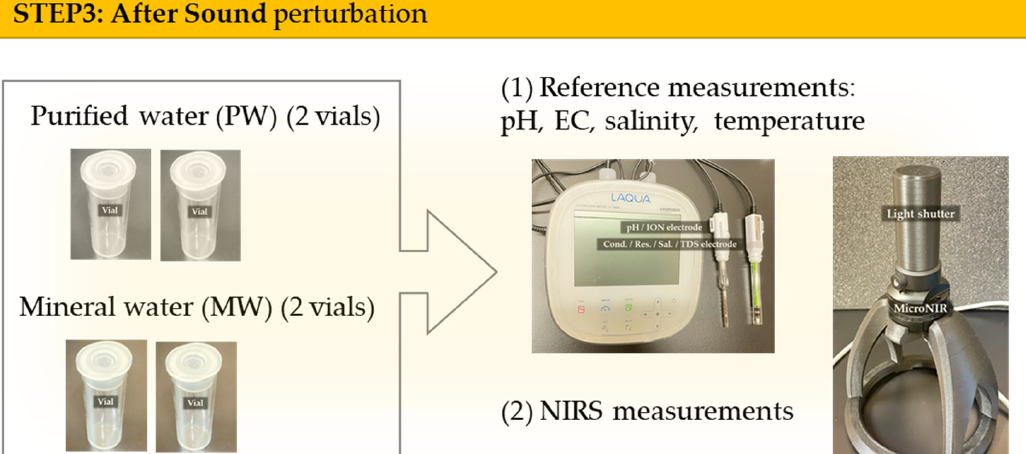
Figure 9. Schematic representation of the experimental flow. The experiment was first performed in steps 1–3 with the frequency of music set to 432 Hz, and then the entire procedure was repeated with the only difference being setting of the frequency to 440 Hz.